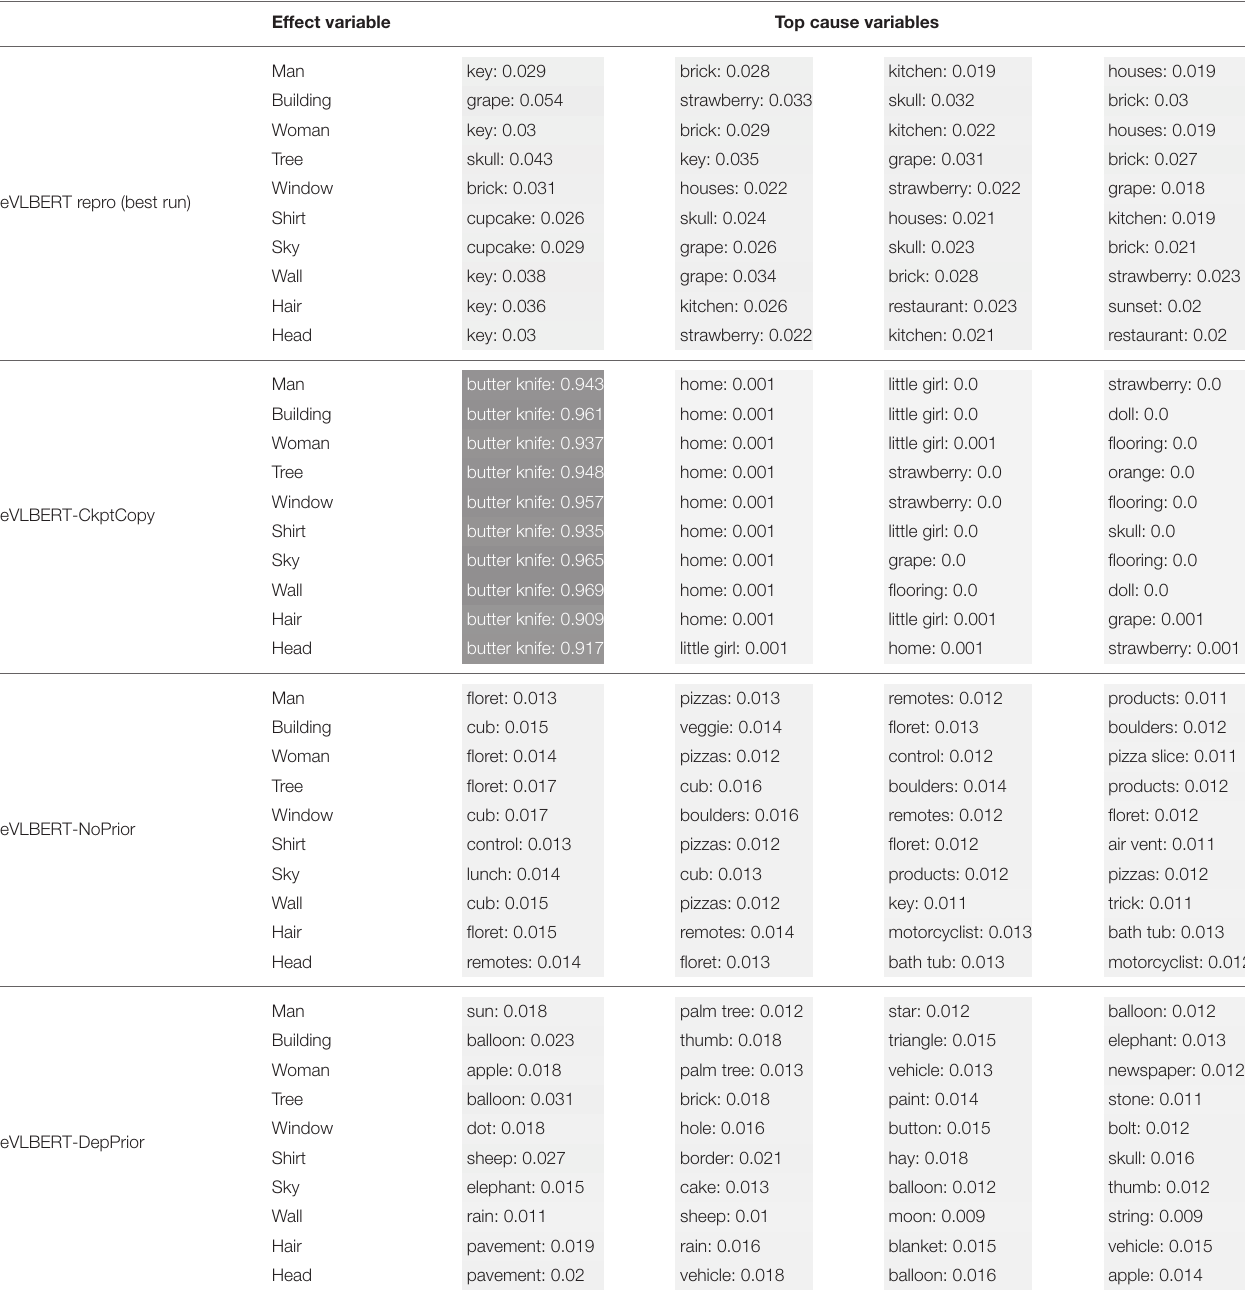
TABLE 6 | The average top predicted “causes” in the confounder dictionary Z and the corresponding average attention score α [ c ] for the 10 most common objects (in bold in the leftmost column). Effect